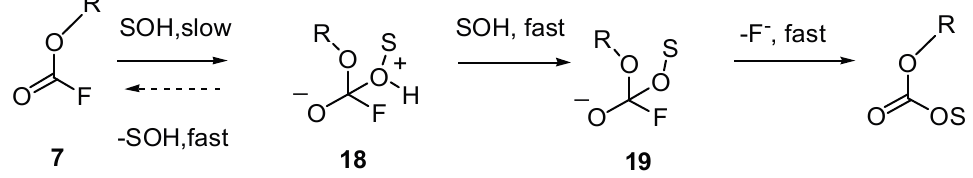
Figure 14. Stepwise addition-elimination mechanism [29,77,87,89] for solvolyses